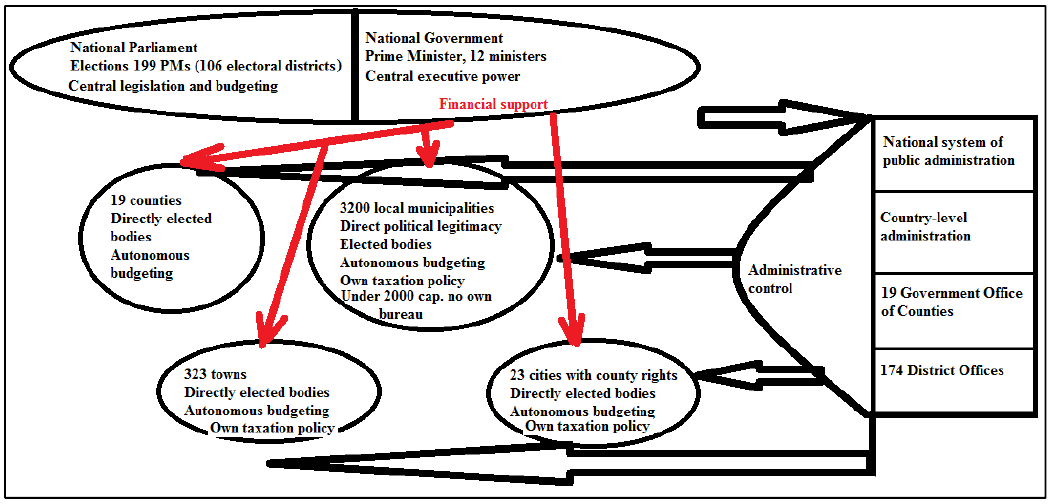
Figure 3. Elements of the Hungarian system of government and governance (authors’ edition).